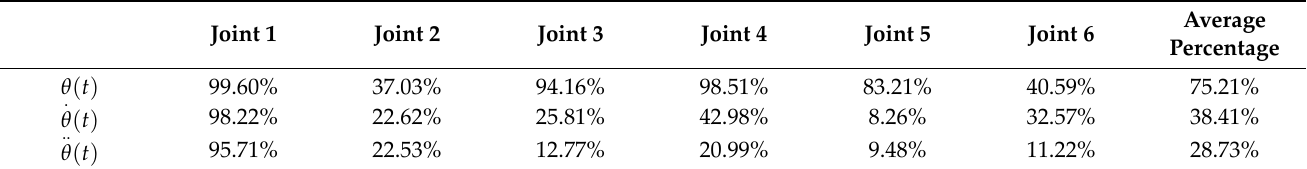
Table 10. Angular position, angular velocity, and angular acceleration of each joint accounted for the maximum constraint percentage.